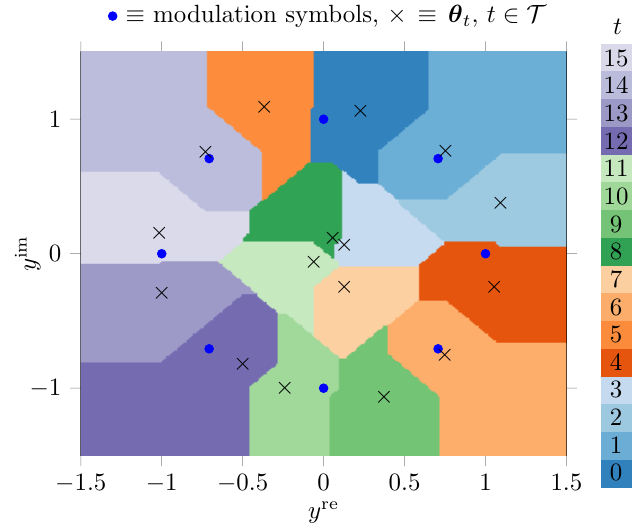
Figure 7. Quantization regions for the output of an AWGN channel with 8-PSK modulation in the = 16 constructed with the genetic algorithm. complex plane for σ 2 n = 0.5, |T |